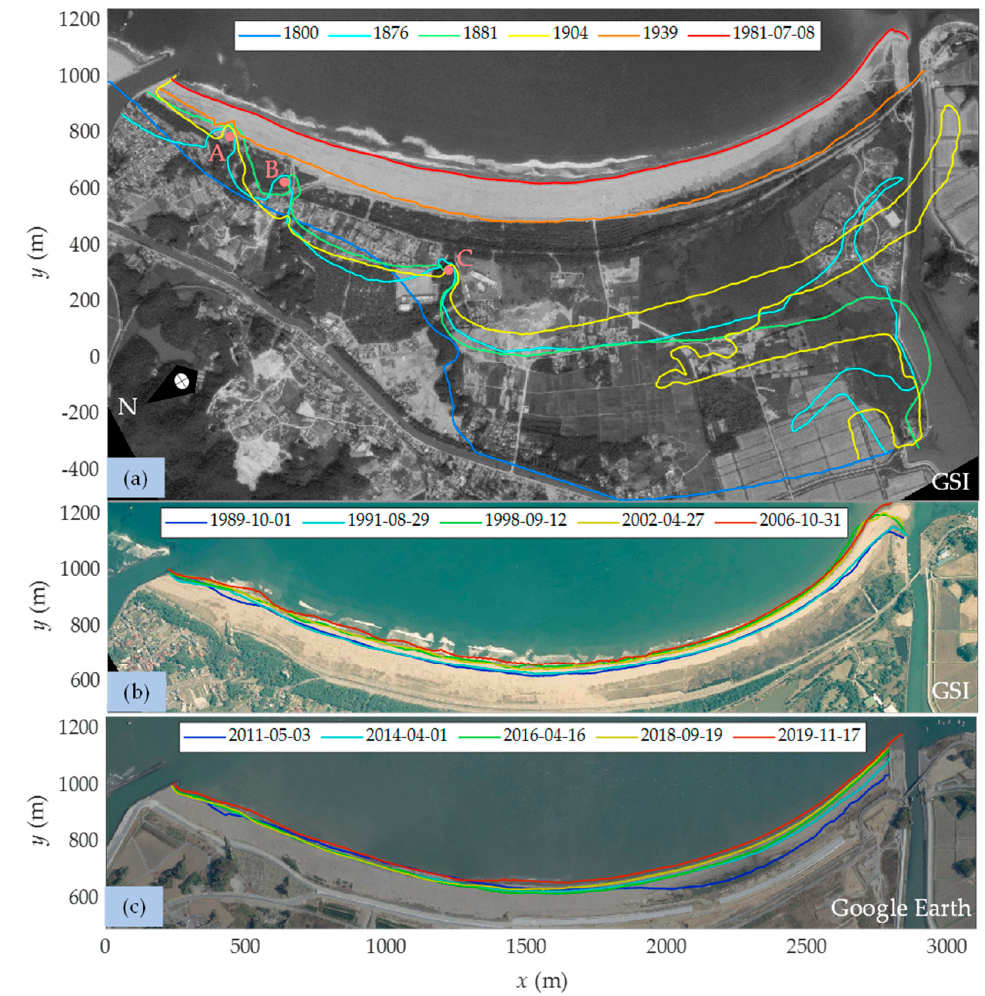
Figure 7. Historical shorelines (1800~2019). ( a ) Before the constructions of detached breakwaters and headlands. ( b ) Before the 2011 tsunami. ( c ) After the 2011 tsunami.